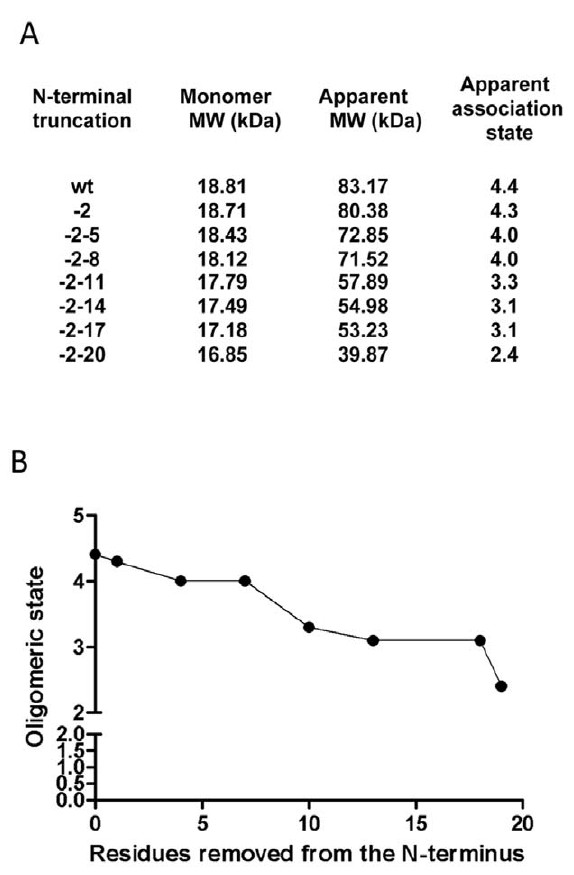
Figure 5. Influence of N-terminal residues on PAS1 oligomer- isation state in the context of the 1–140 construct. (A) SEC analysis of wild-type and truncated variants (see Figure 3 for N-terminal sequences). In each case, the hexa-histidine-containing tag encoded by the pETNdeM-11 vector provides 26 additional residues at the N- terminus. SEC was performed at a protein concentration of 106 m M (expressed in monomeric terms). (B) The association state determined in (A) for each protein is plotted against the number of residues removed from the N-terminus.